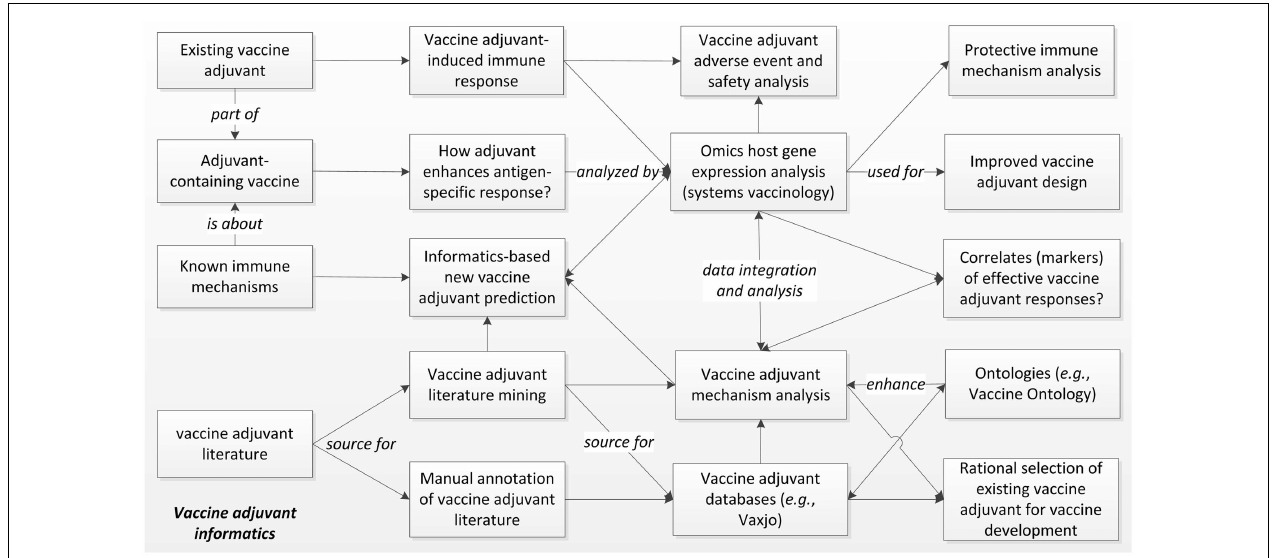
responses, and support specific vaccine adjuvant and vaccine design.The large amount of vaccine adjuvant literature can also be utilized for manual and computer-assisted literature mining, leading to integrated mechanism analysis and database generation.The data can be logically represented and stored in biomedical ontologies that further improve literature mining.Vaccine adjuvant informatics also supports rational design of new adjuvants and selection of existing adjuvants for new vaccine